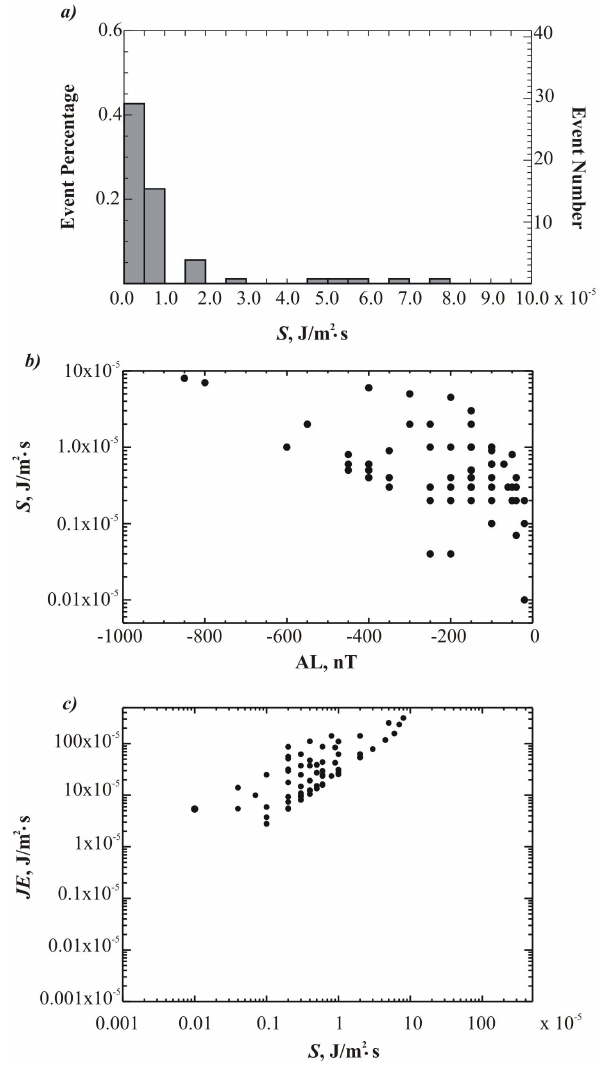
Fig. 16. (a) Statistical distribution of values of the Poynting flux, S observed during the intervals of the electromagnetic perturbations associated with high velocity field-aligned ions. (b) Scatterplot of the Poynting flux versus AL index. (c) Scatterplot of kinetic energy flux JE , transferred by high velocity field-aligned ions versus the corresponding values of the Poynting